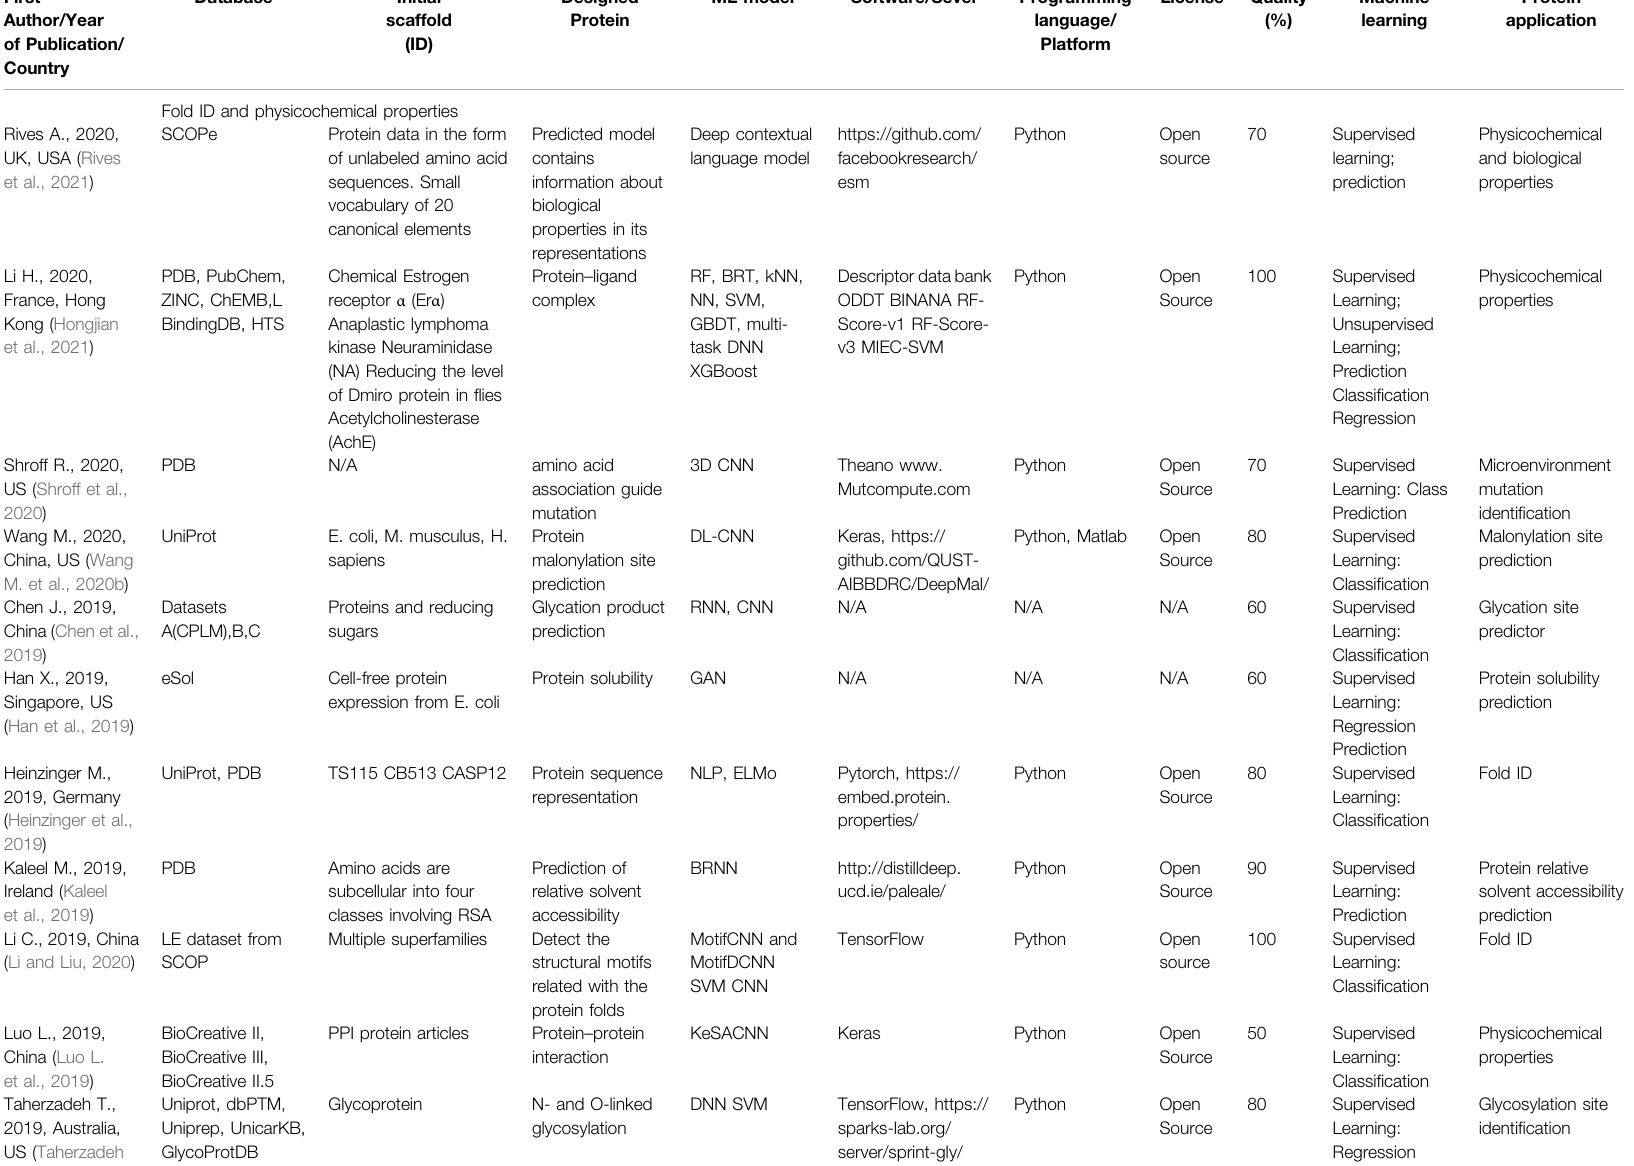
TABLE 4 | An overview of the fold id, physicochemical properties, and protein classi fi cation articles with the quality